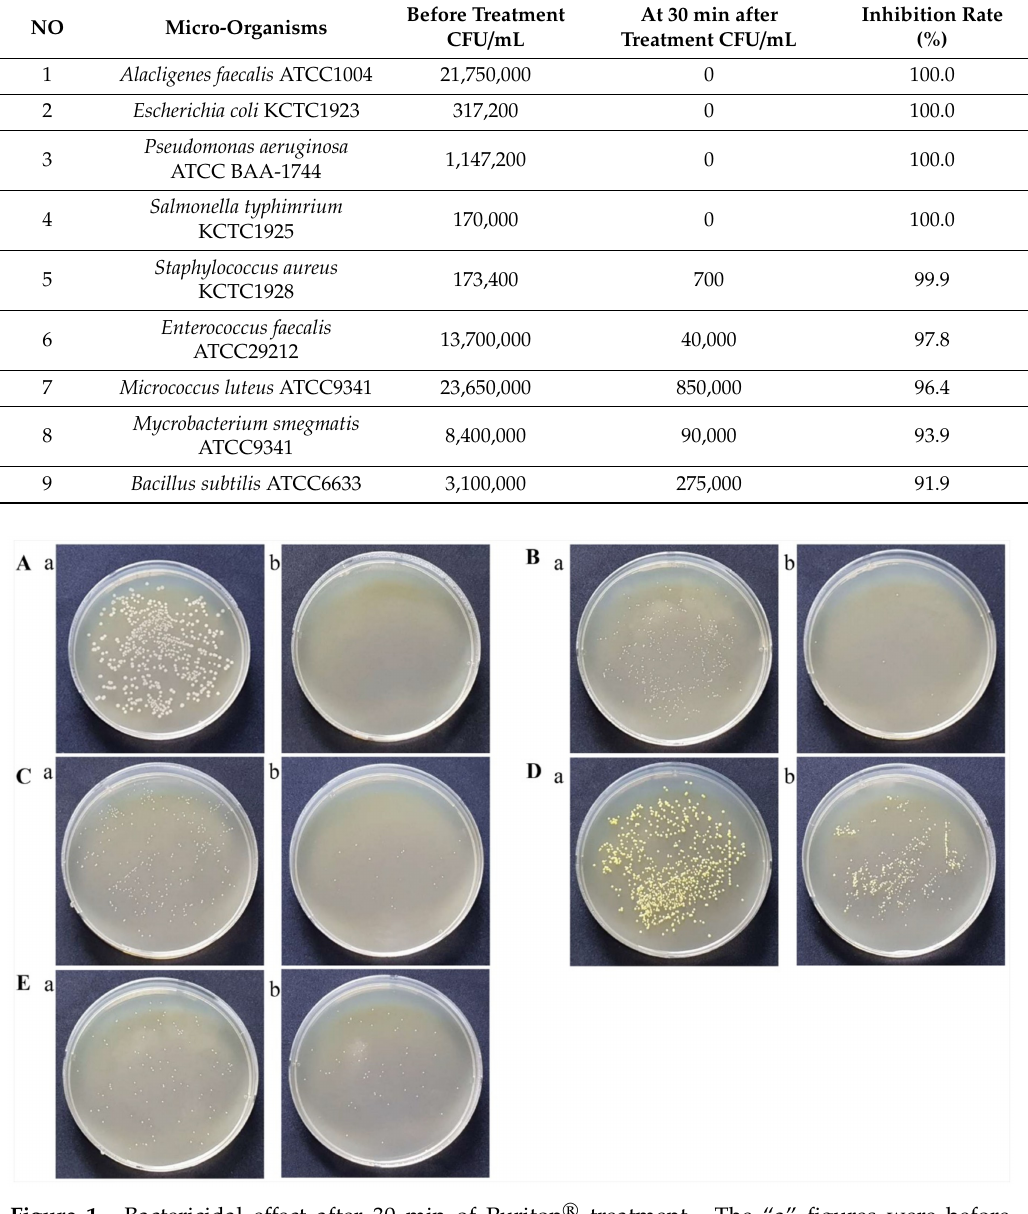
Figure 1. Bactericidal e ff ect after 30 min of Puriton ® treatment. The “a” figures were before Puriton ® treatment, and the “b” figures were after 30 min of Puriton ® treatment. Puriton ® e ffi ciently suppresses bacterial proliferation. ( A ) Alcaligenes faecalis ATCC1004; ( B ) Enterococcus faecalis ATCC29212; ( C ) Mycobacterium smegmatis ATCC9341; ( D ) Micrococcus luteus ATCC9341; ( E ) Bacillus subtilis